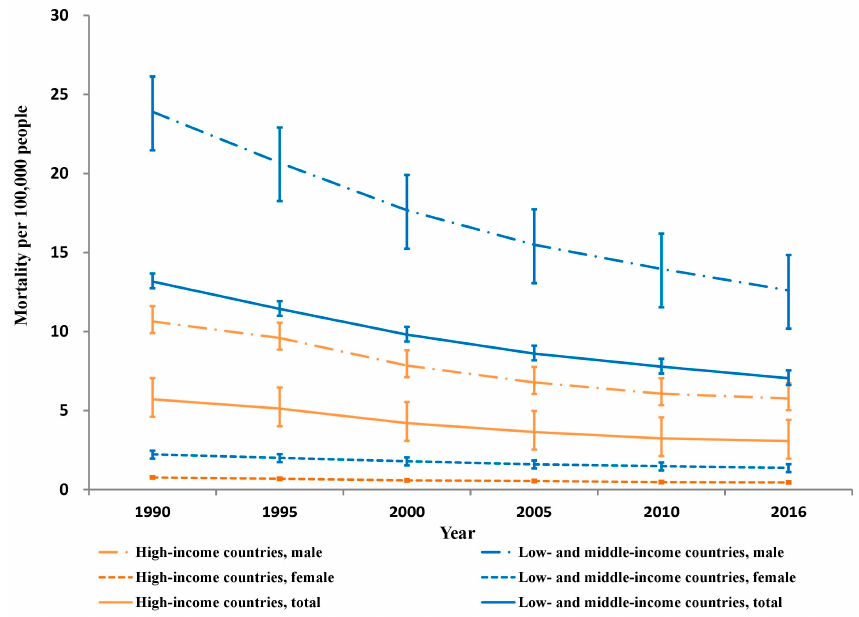
Figure 1 . Unintentional occupational injury mortality per 100,000 persons by country income and sex, 1990–2016.